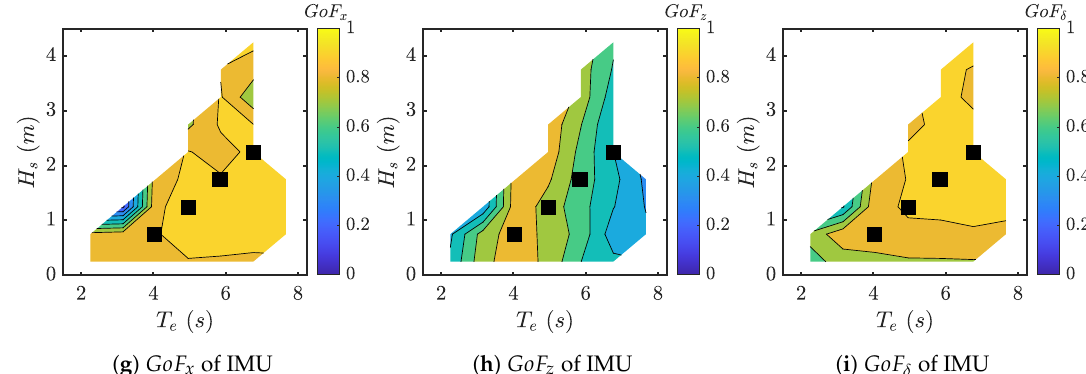
Figure A1. GoF results with noisless measurements for each measurement framework obtained with the KF. The first row refers to the MRU framework ( a – c ), the second to the IMU+DGPS framework ( d – f ), the thrid to the IMU framework ( g – i ).